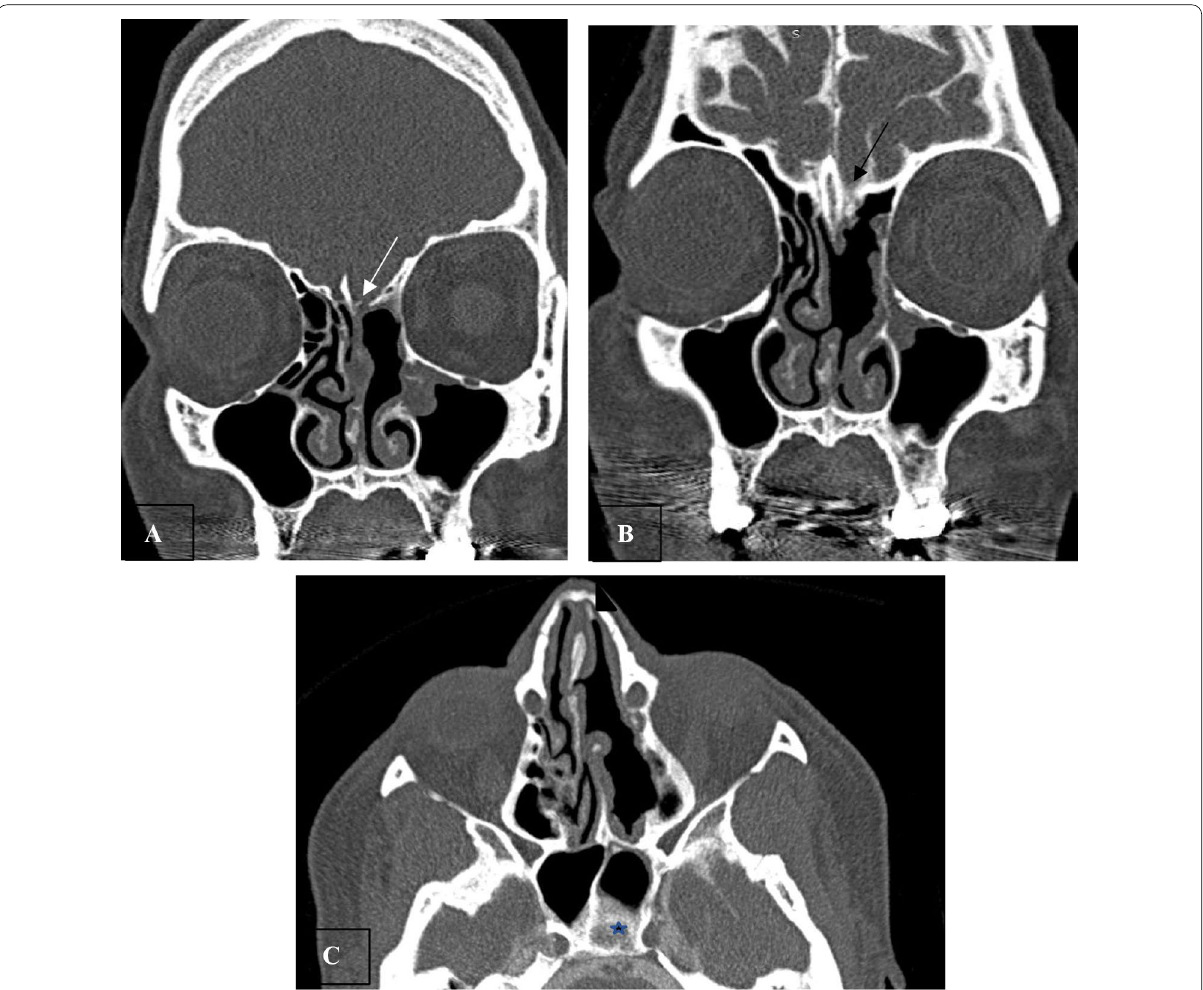
mildly deviated nasal septum to the right side ( A and B